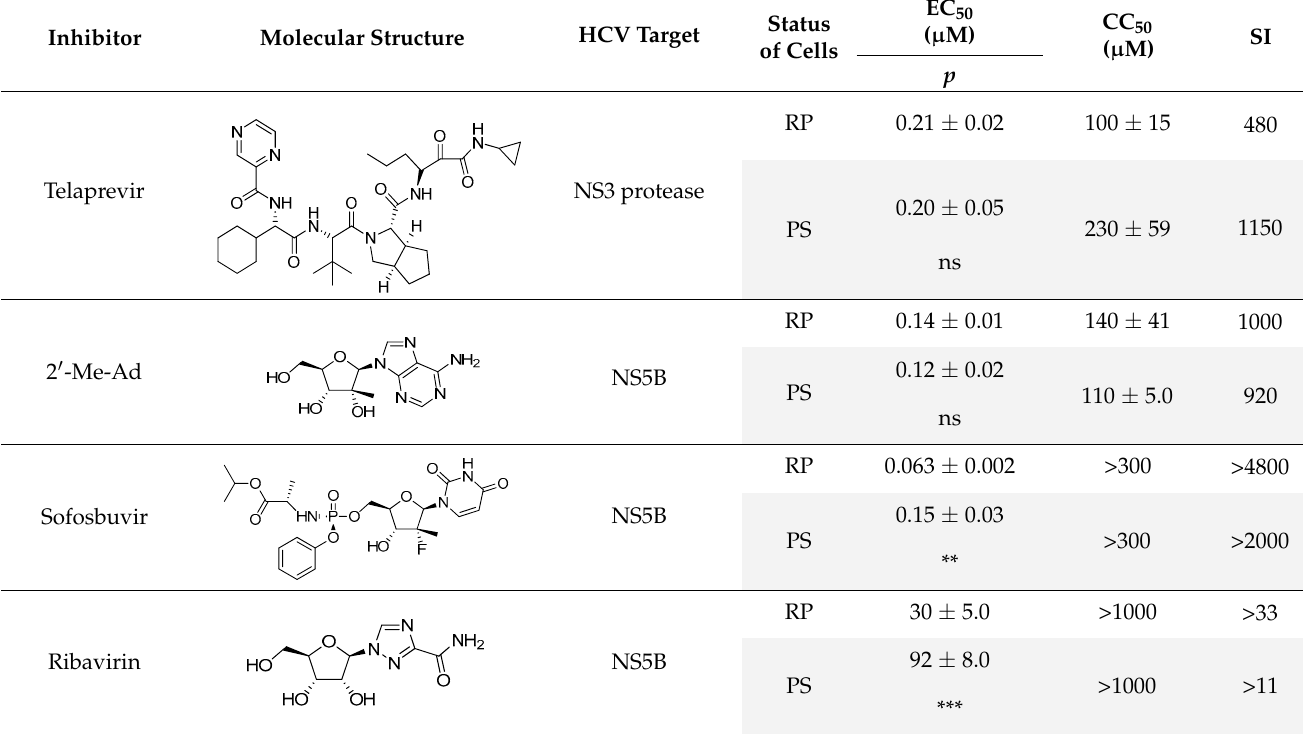
Table 1. Testing of DAAs in regularly proliferating (RP) and in pre-senescent (PS) Huh7-luc/neo cells. Inhibitor Molecular Structure